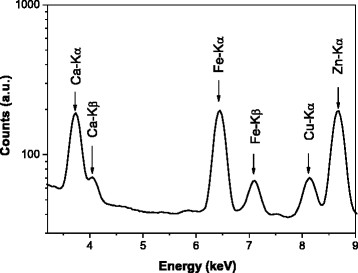
Typical EDXRF breast cancer spectrum.